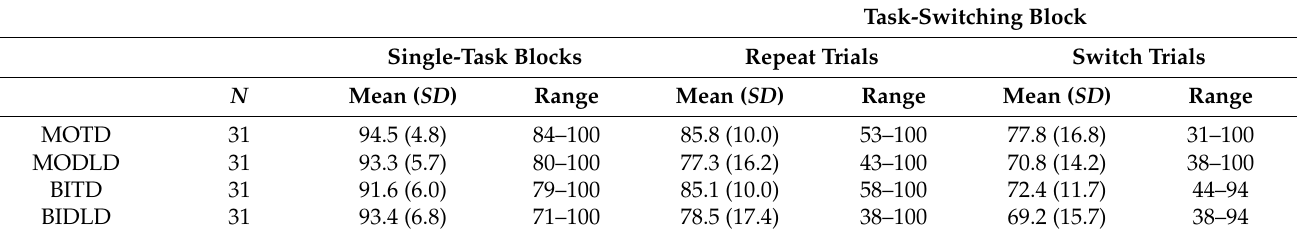
Table 3. Mean % accuracy scores of the four groups of